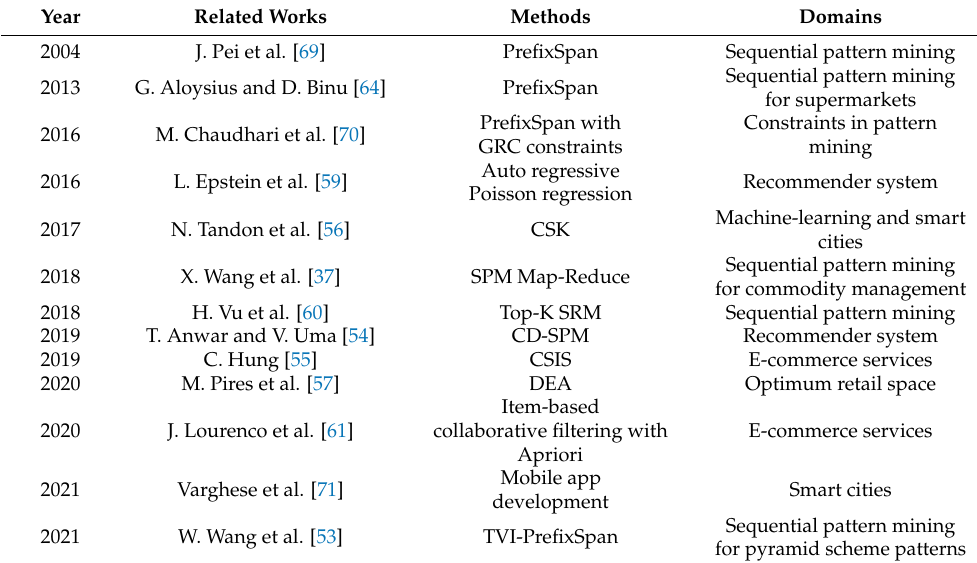
Table 1. Related works, along with their methods and